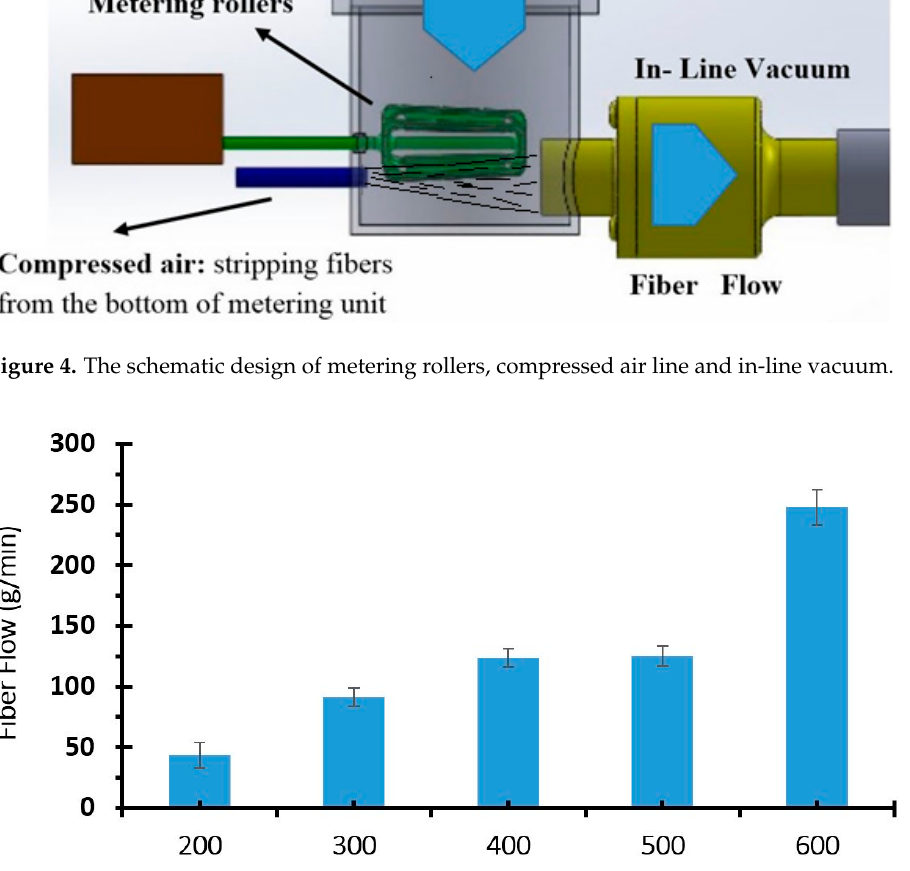
Materials 2016 , 9 , 548 7 of 12